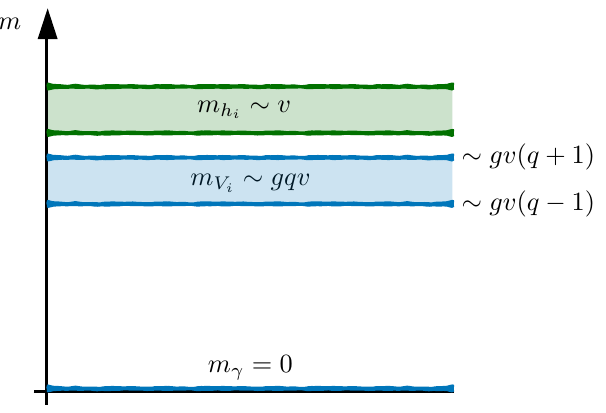
Figure 2 . Typical mass spectrum of vector clockwork constructions. A massless photon remains in the spectrum, followed by N massive vectors at scale m V of the model, N scalar (cid:12)elds are also present, with masses m h